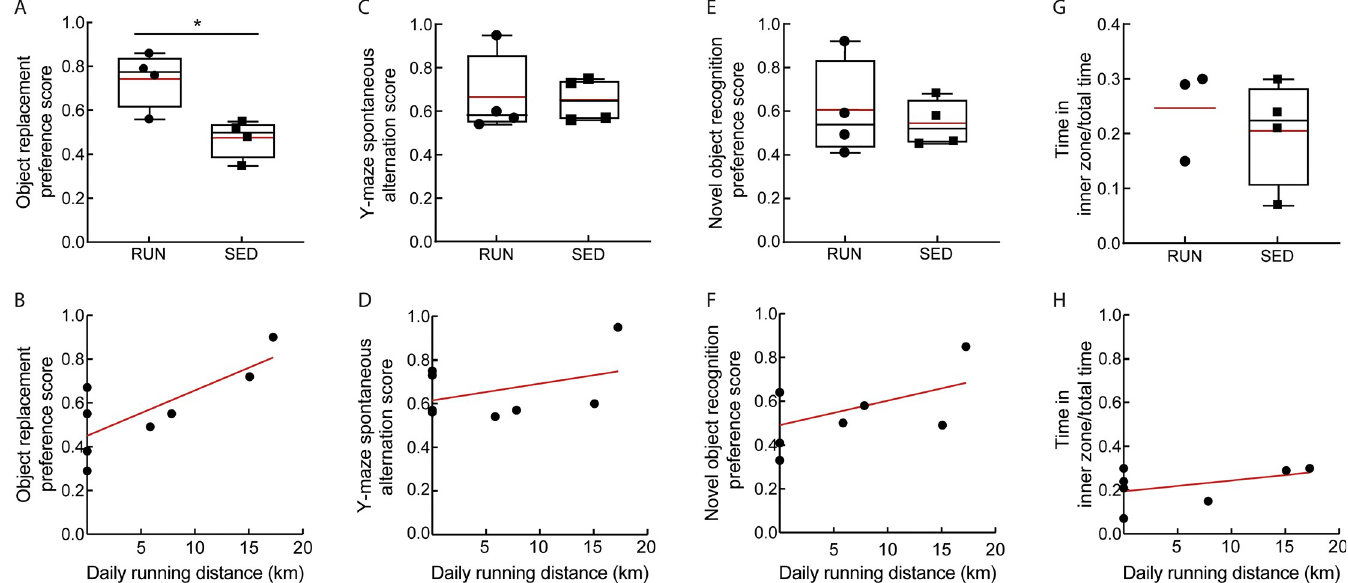
Fig 2. Running improved performance in the object replacement test, but did not show strong effects in other short-term memory tests. All behavioral testing results are shown for running (RUN) and sedentary (SED) APP/PS1 mice. A Preference score for OR (P = 0.01). B Correlation between OR preference score and total running distance (R 2 = 0.6; P = 0.03). C Spontaneous alternation score in Y-maze. D Correlation between spontaneous alternation and total running distance. E Preference score in NOR test. F Correlation between NOR preference score and total running distance. G Time spent in the arena center in the open field test. One value was excluded in the running group due to a software failure during the test. H Correlation between time spent in the arena center and total running distance. Animal numbers: RUN: n = 4 (OF: 3); SED: n =